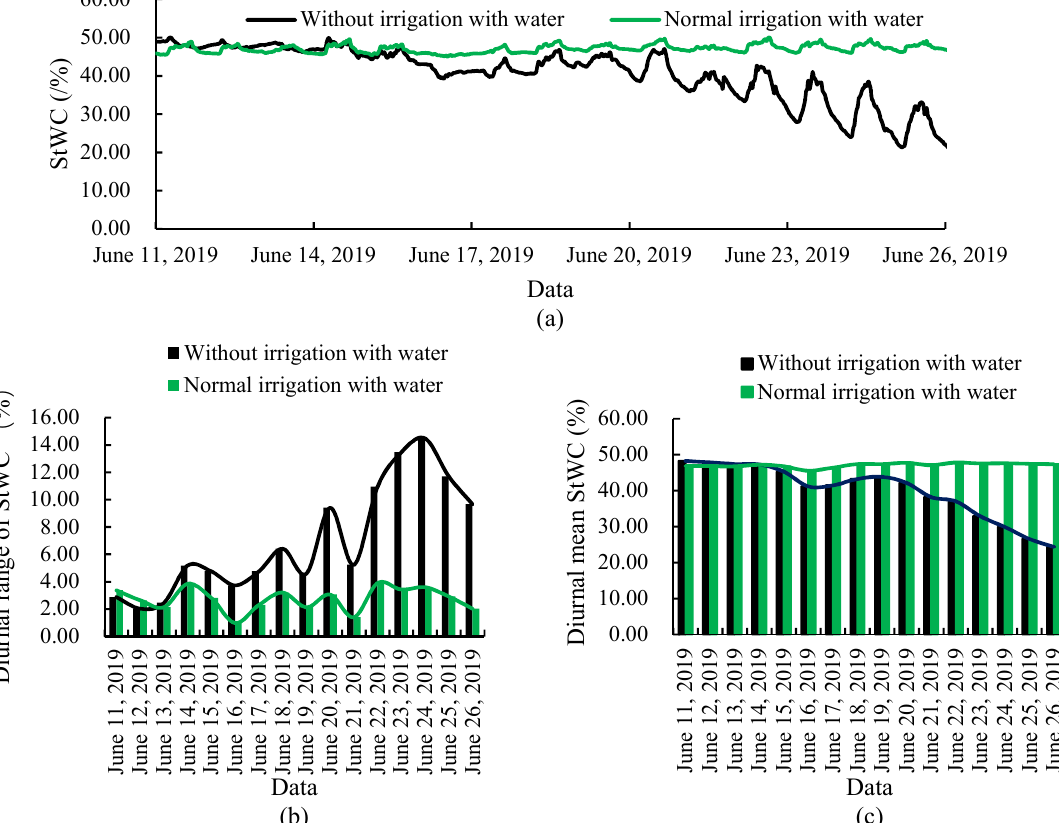
Figure 8. StWC changes in normal irrigation with water and without irrigation with water: ( a ) StWC of Malus micromalus Makino . ( b ) Diurnal range of StWC for Malus micromalus Makino . ( c ) Diurnal mean of StWC for Malus micromalus Makino .